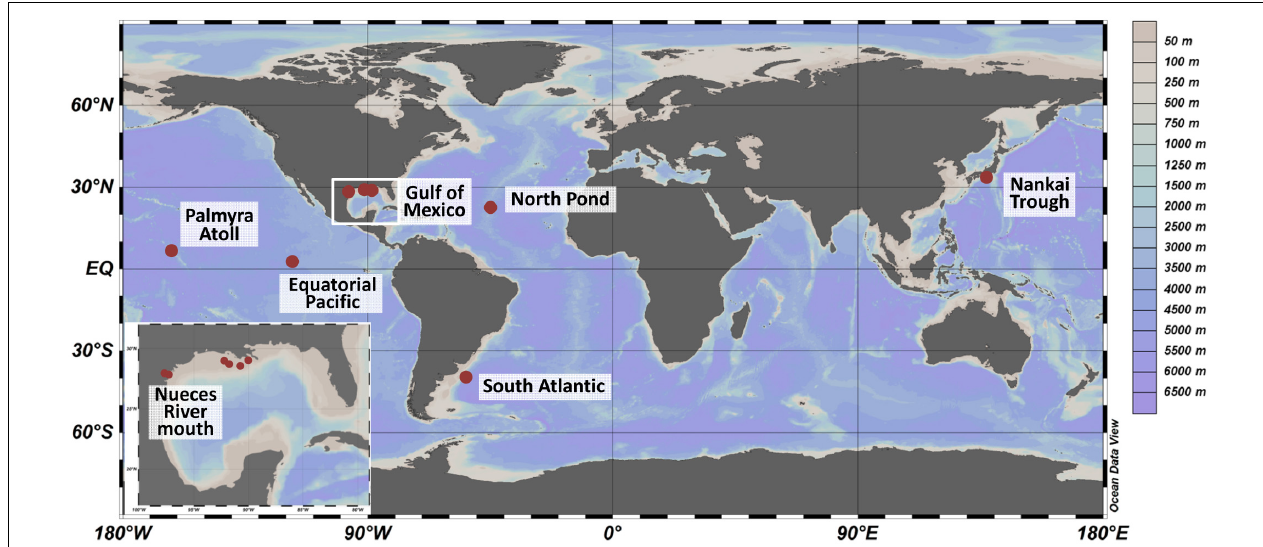
FIGURE 1 | Sampling sites worldwide (large panel) and in the Gulf of Mexico (small panel). Sediments were collected from 2007 to 2012 during several expeditions. The color scale represents water depths at the various sites. The map was created using OceanDataView (Schlitzer,